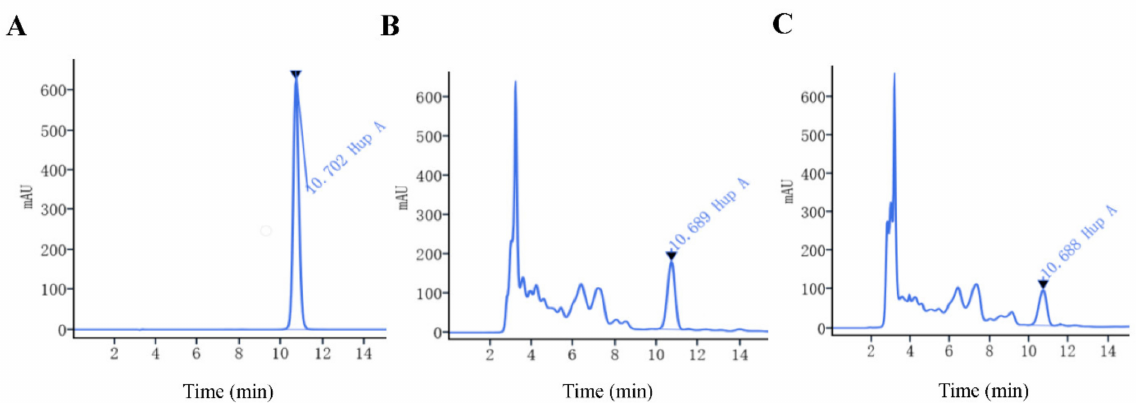
Figure 4. Chromatogram of the Huperzine A in different sample. ( A ) Chromatogram of the HupA standard. The retention time for HupA standard was 10.702 min. ( B ) Sample chromatogram of H. serrata extract (plant collected in Fujian Table 5). The retention time for the HupA was 10.689 min. ( C ) Sample chromatogram of the FJ’ propagated extract (plant collected In vitro). The retention time for the HupA was 10.688